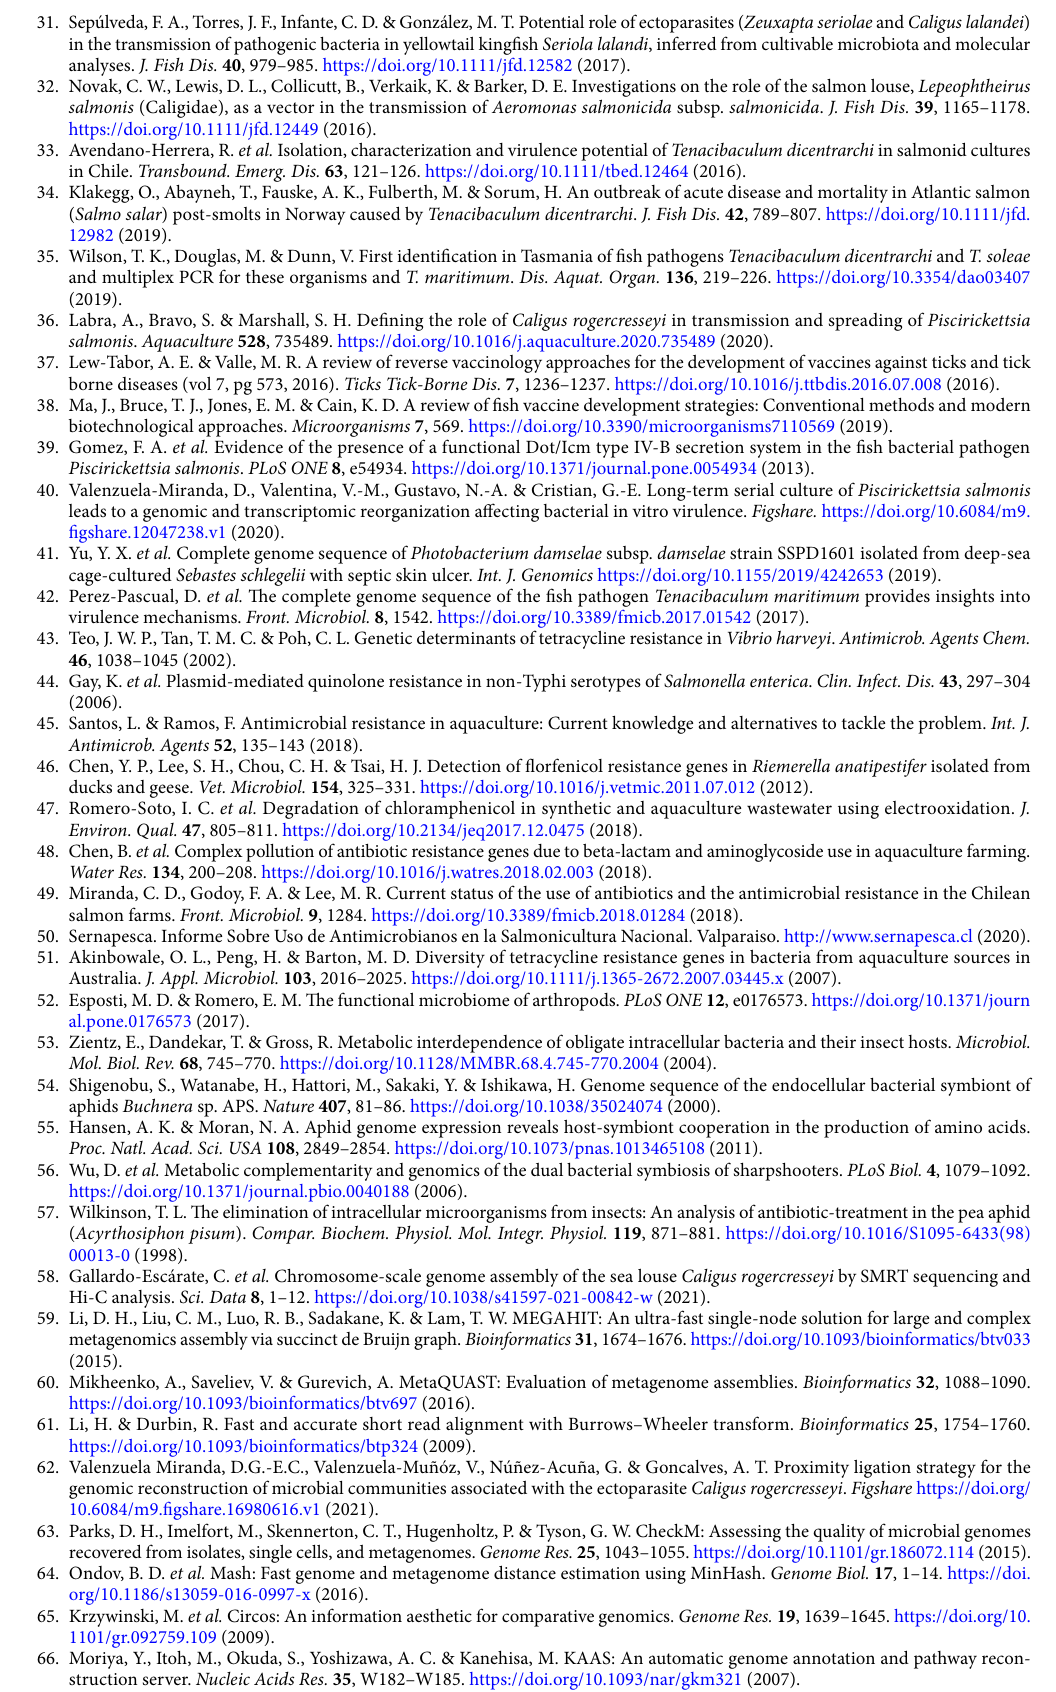
figsh are. 12047 238. v1 (2020). 41. Yu, Y. X. et al. Complete genome sequence of Photobacterium damselae subsp. damselae strain SSPD1601 isolated from